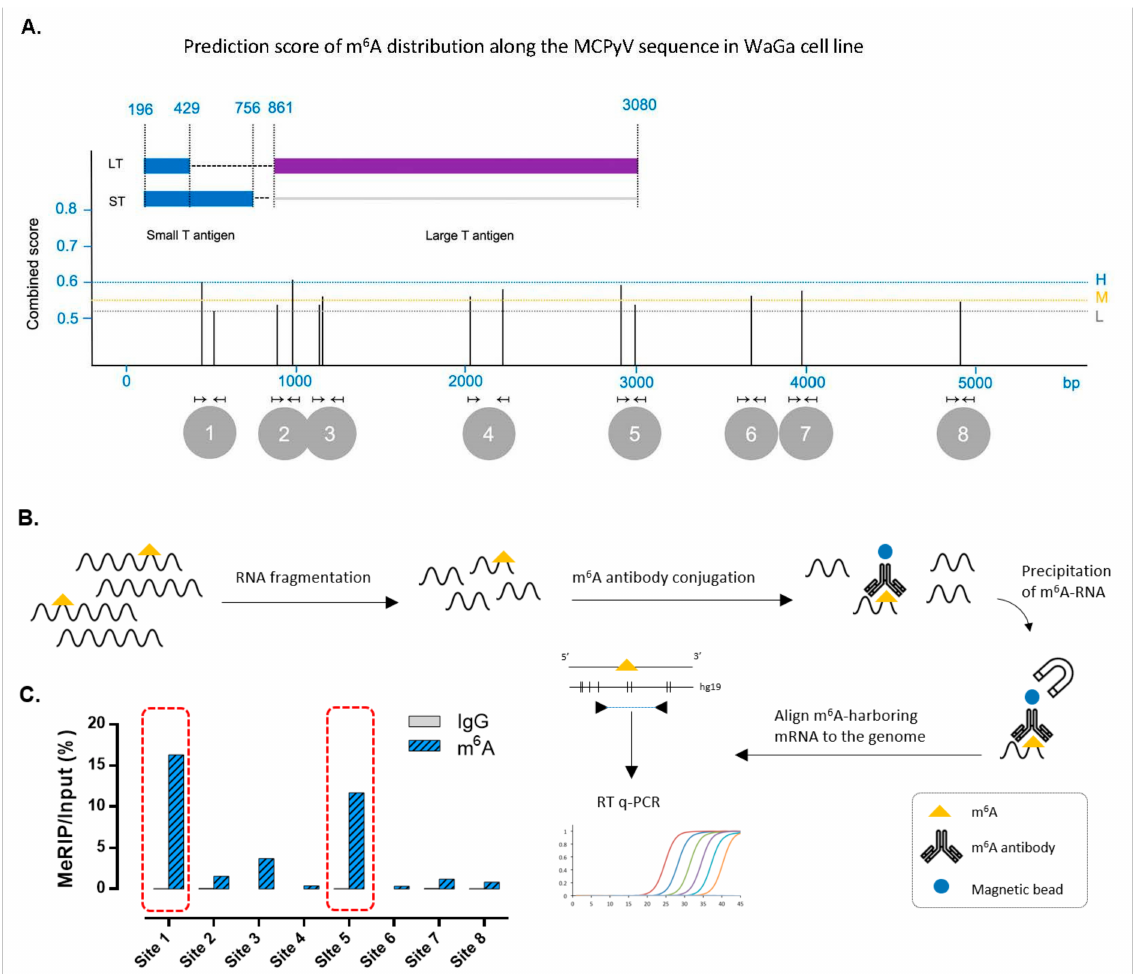
Figure 3. ( A ) Prediction score of m 6 A distribution along WaGa cell line according to the sequence-based RNA adenosine methylation site predictor (SRAMP) algorithm. Y axis shows the combined score at di ff erent levels of high (H), moderate (M), and low (L) probability. Vertical bars show the score for m 6 A sites. X axis shows MCPyV genome in base pair resolution. Arrows show the location of qPCR primers designed to validate m 6 A sites. Annotated features of MCPyV genome are shown above the X axis. ( B ) Schematic figure shows the methylated RNA immunoprecipitation (meRIP) method followed by qPCR to validate predicted m 6 A sites. ( C ) MeRIP-qPCR results show site 1 and site 5 to be amplified, indicating the presence of m 6 A in these two regions. Samples are normalized to non-crosslinked input to remove background noise. Anti-IgG antibody is used as